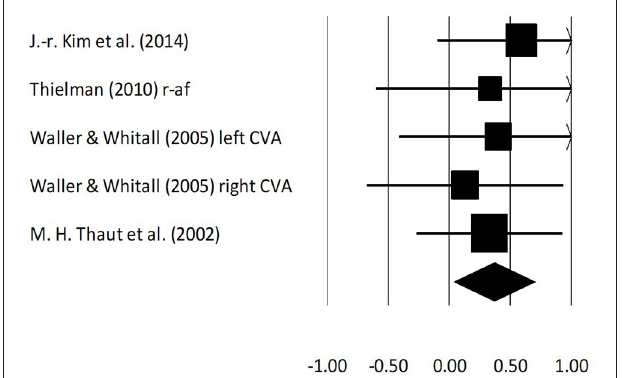
FIGURE 6 | Forest plot illustrating individual studies evaluating the effects of rhythmic auditory cueing, and real-time auditory feedback on elbow range of motion among post stroke patients. Weighted effect sizes; Hedge’s g (boxes) and 95% C.I (whiskers) are presented, demonstrating repositioning errors for individual studies. The (Diamond) represents pooled effect sizes and 95% CI. A negative effect size indicated reduction in elbow range of motion depicting poor arm functioning; a positive effect size indicated enhancement in elbow range of motion depicting better arm functioning. (r-af, Real-time auditory feedback; low, Low performance group; high, High performance group; left CVA, Left sided cerebrovascular accident; right CVA, Right sided cerebrovascular